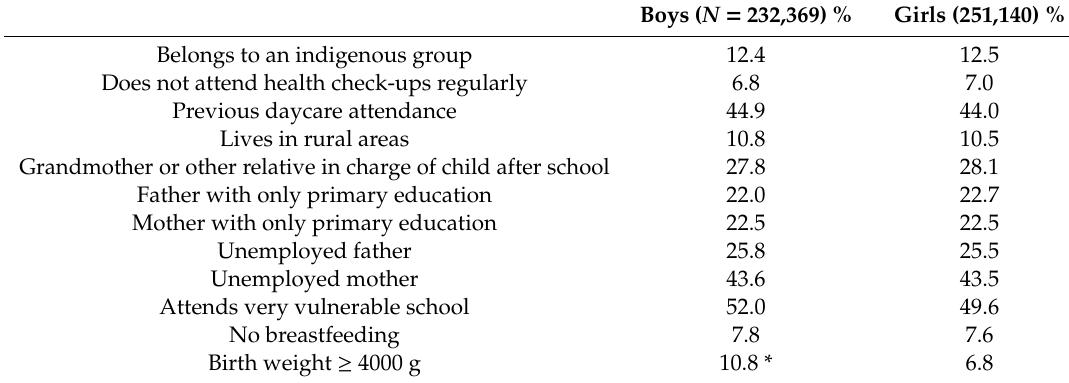
Table 1. Socioeconomic and health-related characteristics of the population of prekindergarten (2011–2015) by sex (percentage).